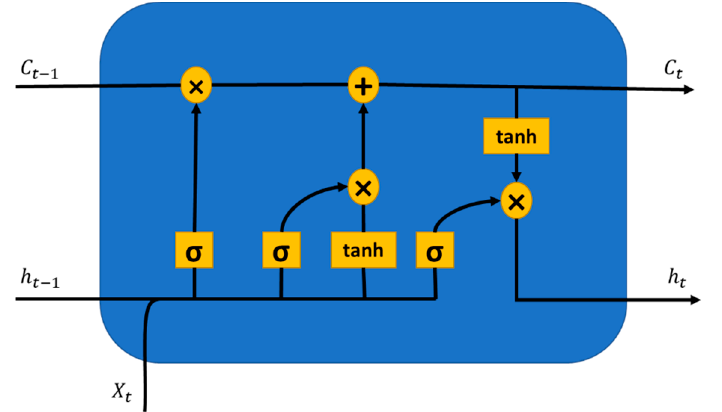
Figure 2. Unit cell of